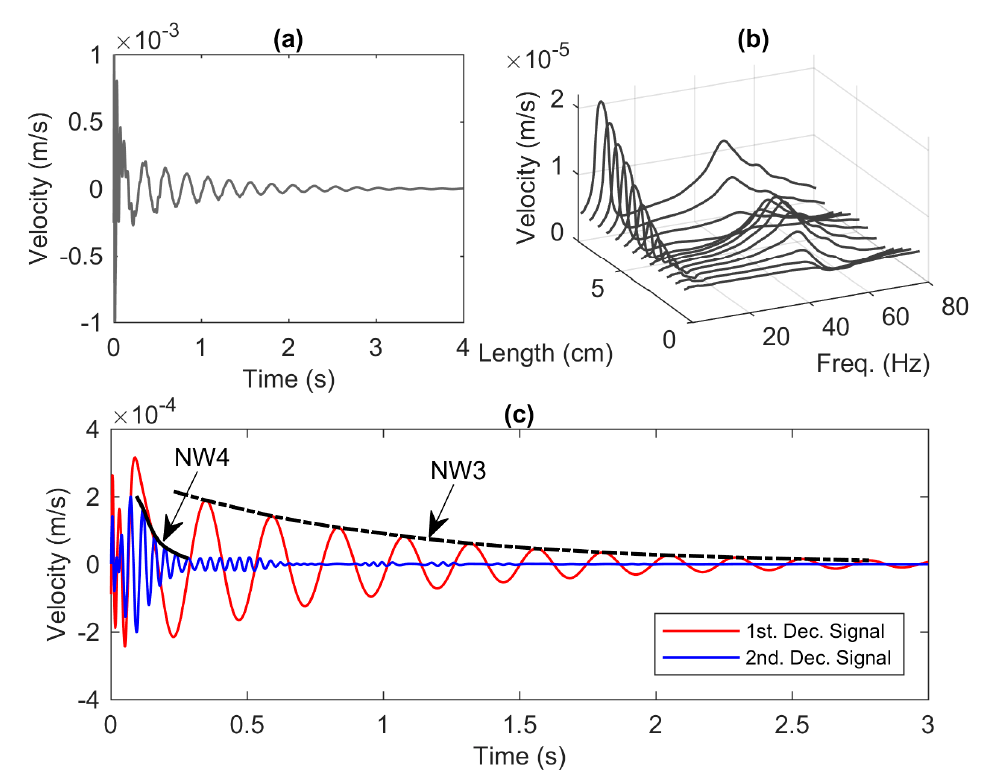
Figure 13. ( a ) Time series of the velocity at the tip of the beam, ( b ) velocity amplitude vs. frequency at several locations along the beam, and ( c ) time series of the first and second decomposed signals.